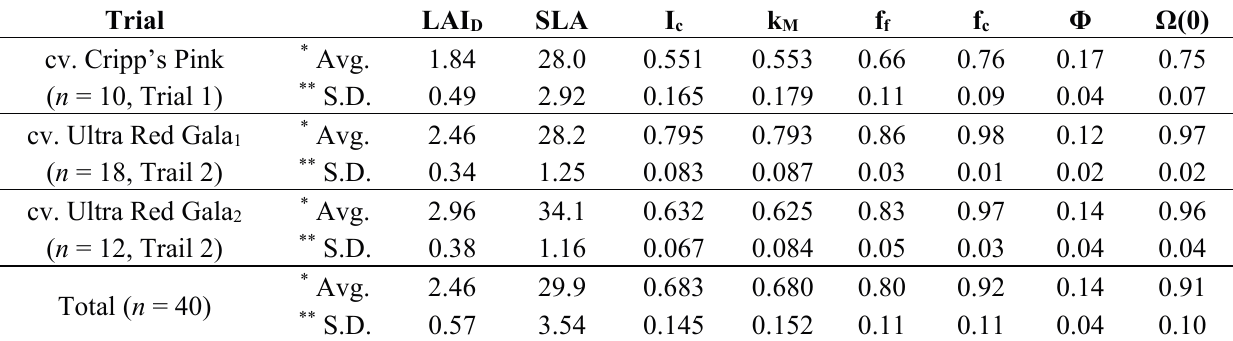
Table 1. Average and standard deviation values obtained for destructive leaf area index (LAI D ), specific leaf area (SLA), light intercepted by the canopy (I c ), measured extinction coefficient (k M ), fraction of foliage cover (f f ), crown cover (f c ), crown porosity ( Φ ) and clumping index at the zenith angle ( Ω (0)) for the both trial sites. LAI